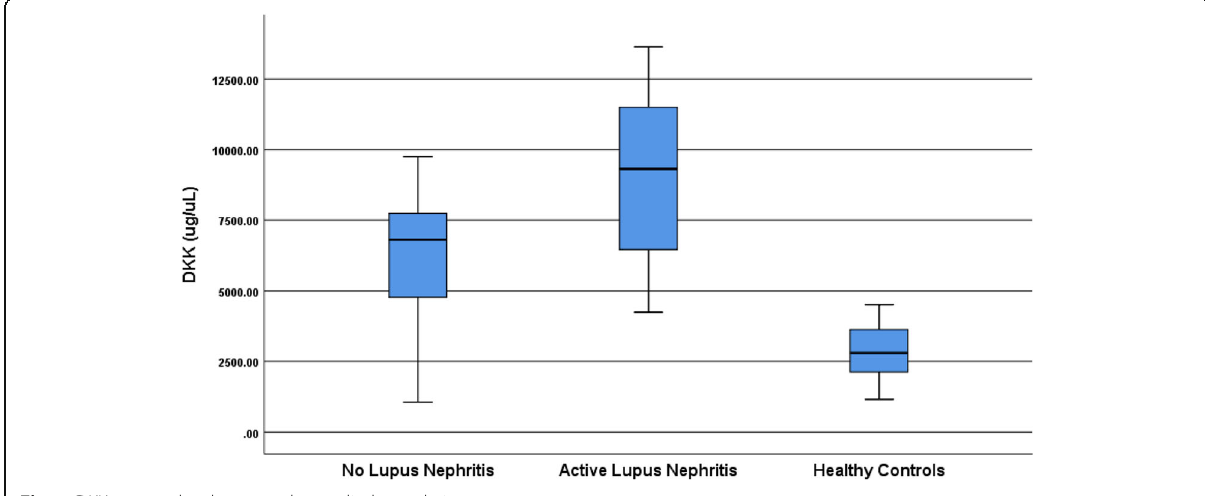
Fig. 1 DKK1 serum level among the studied population